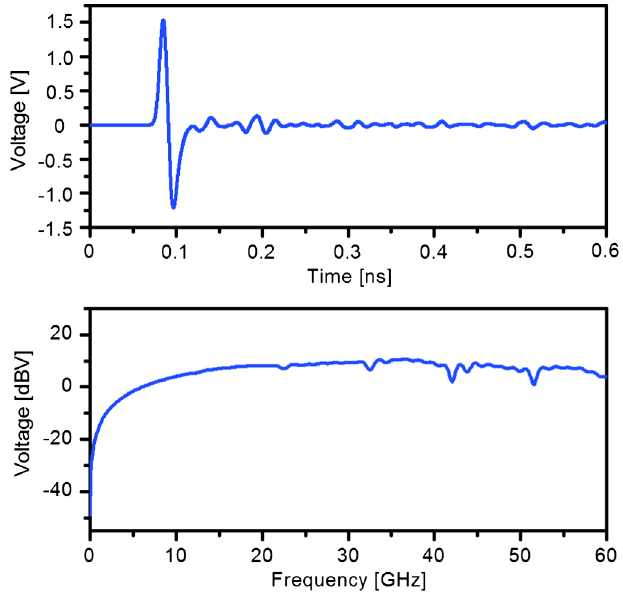
FIG. 3. Simulation results of one pickup in time domain (top) and the respective frequency spectrum normalized by the spec- trum of the particle beam (bottom).